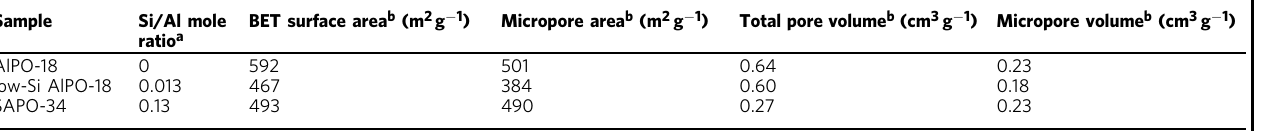
Table 1 Chemical compositions, BET surface areas and pore volumes of the calcined zeolites Sample